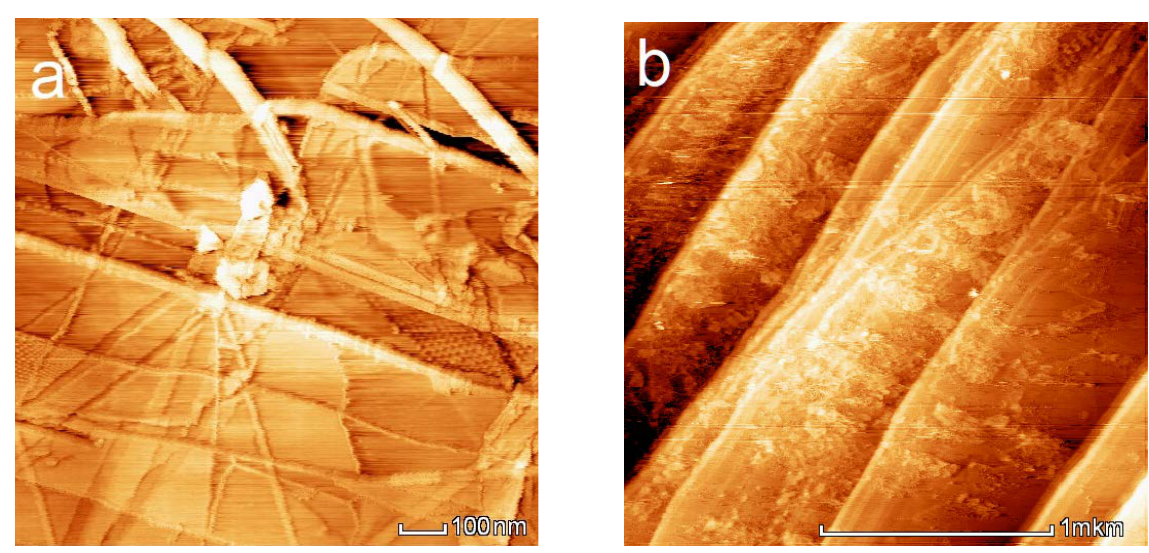
Fig. 4. STM images of ultra thin (a) and thin layers (b) of DPT-nAu on the surfaces of